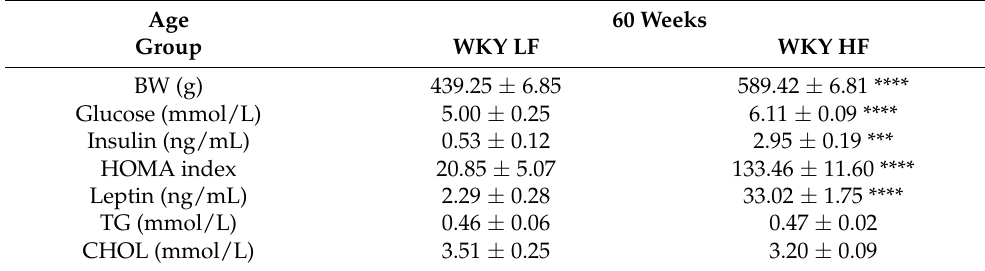
Table 2. Morphometric and metabolic parameters analyzed in fasted plasma of WKY LF and WKY HF before the treatment (60 weeks of